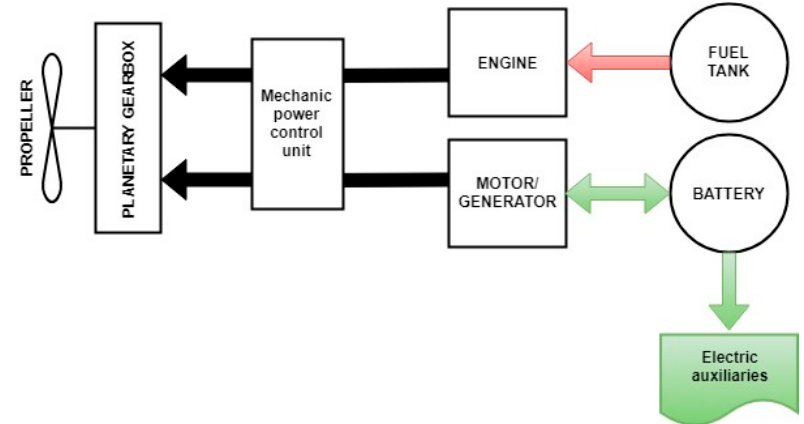
Figure 8. Scheme of the hybrid electric powertrain.